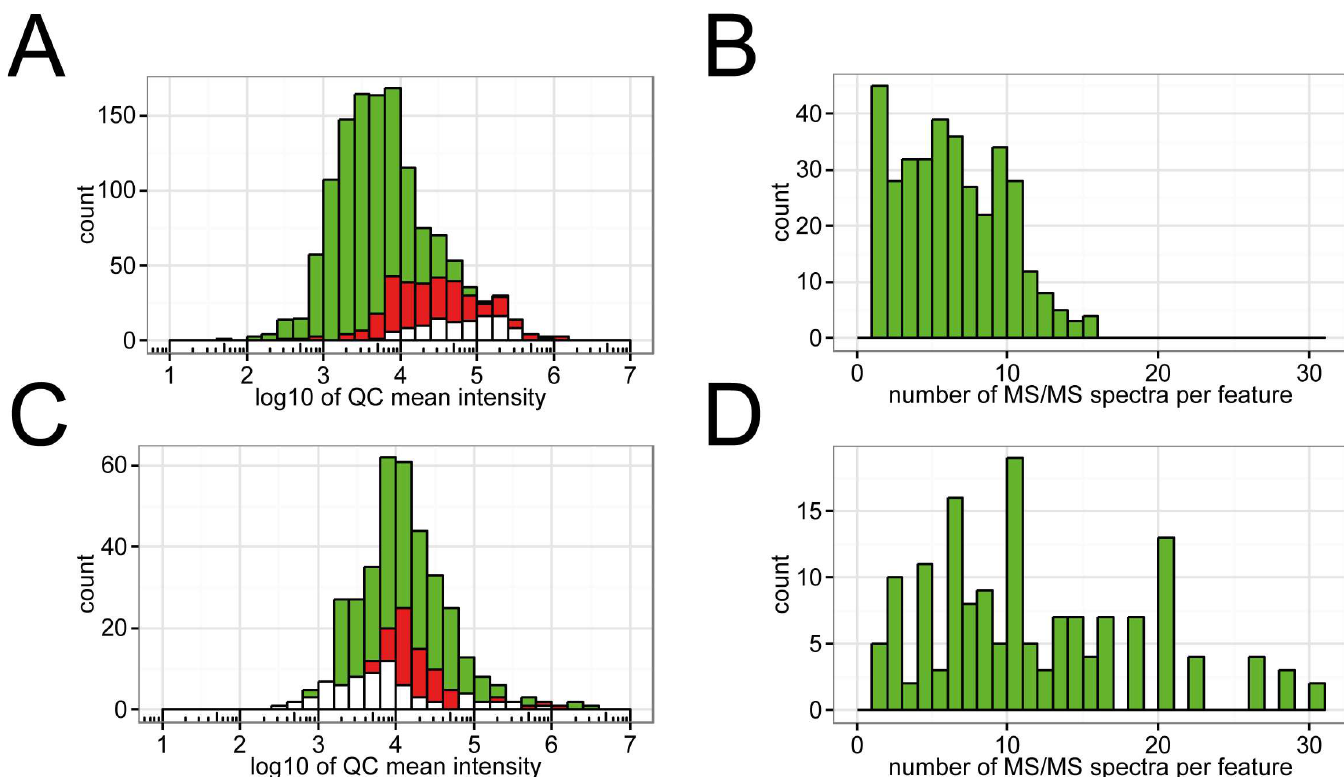
Fig 4. Histogram of intensities of features detected in positive ion mode. (A) The green histogramrepresentsall features, in red are features with one or more associatedMS/MS spectra and the white features havinga FCP > 0.95 in LipidFrag. (B) Histogramof MS/MS spectra per feature in positive ion mode across all 5 technicalreplicates. (C) and (D) show the same for negativeion mode.